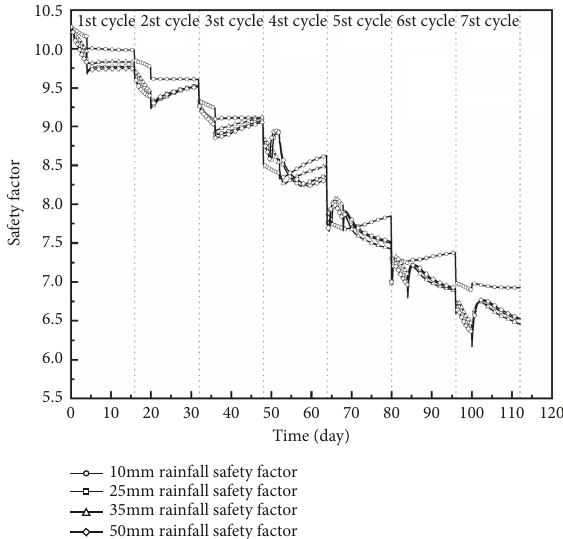
Figure 7: Variation curve of safety factor for different rainfall